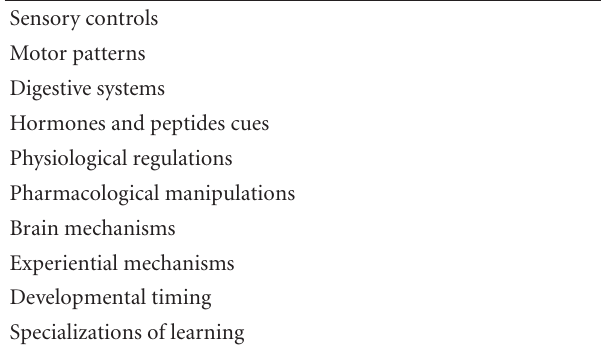
Table 2: Comparisons applied to sucking and feeding behaviors that are used to evaluate whether the development of oral ingestion is better understood as a unitary process or should be dissociated into separate